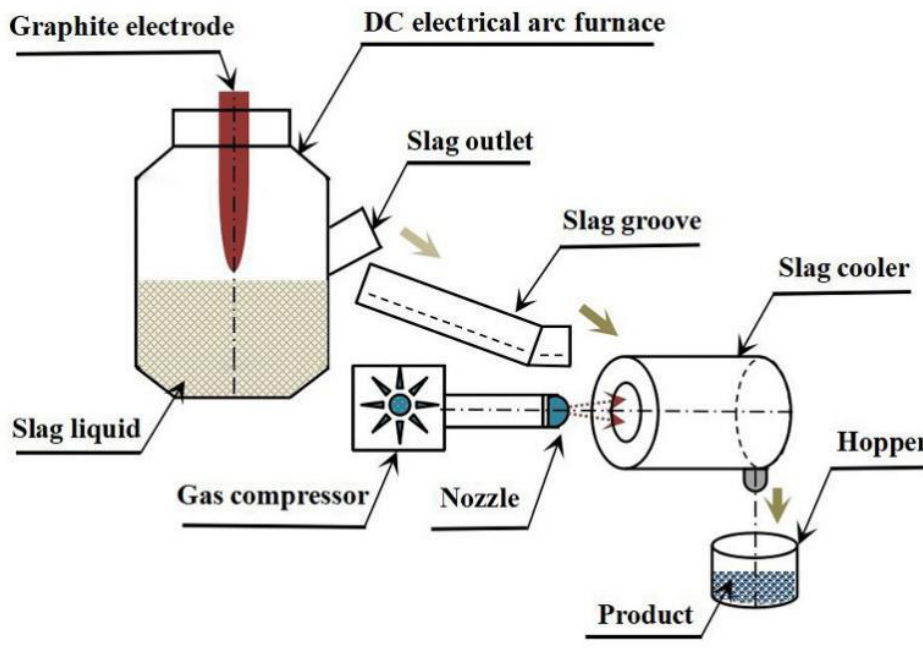
Figure 1. Experimental chart of gas-quenched steel slag abrasive. Polishing experiment: The steel slag abrasives were blended with the polishing fluid (pH = 8) and the abrasive particle was 75~150 µm. Aluminum and copper alloys were taken as the base materials to perform the experiment using the PG-2D polishing machine, which has a disc diameter of 230 mm and a rotation speed of 700 r/min.